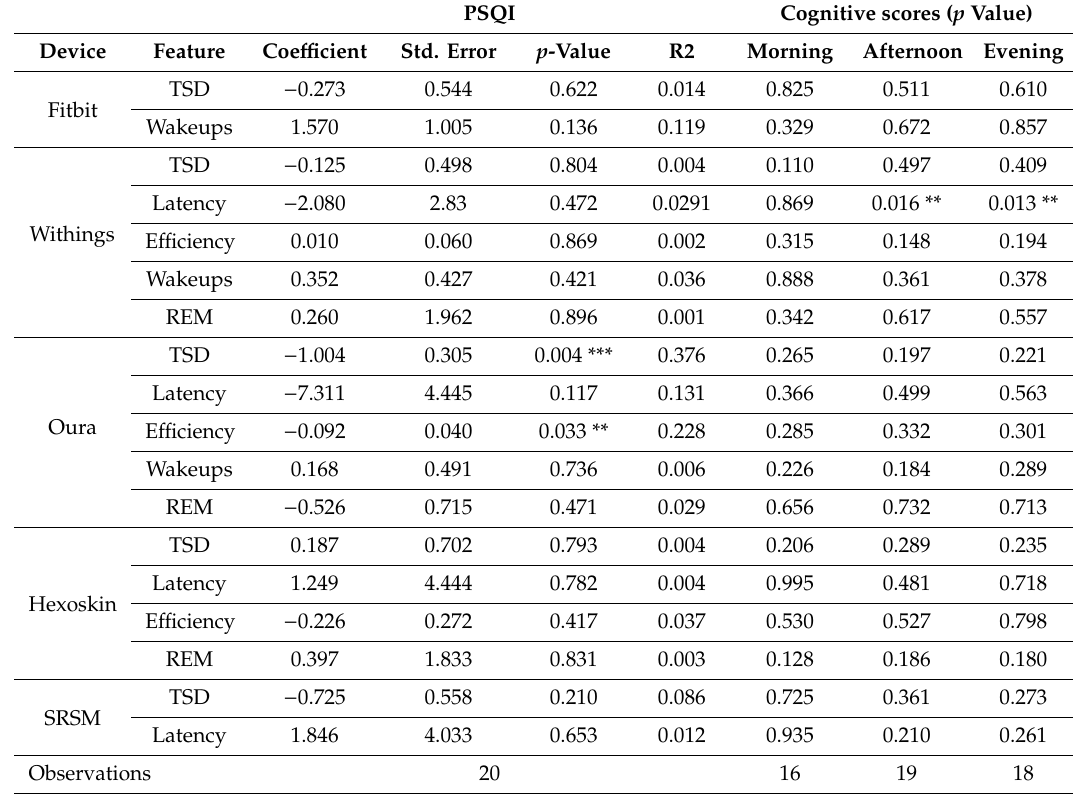
Table 3. Results of multiple univariate linear models for PSQI (left) and cognitive scores across all timepoints (right). For the PSQI-related models, the independent variables were the means of device data for each participant, and the dependent variable was PSQI. The higher the value is on the PSQI, the worse the sleep quality; thus, positive correlations suggest relation to poorer sleep quality. For the cognitive score-related models, the independent variables were the means of device data for each participant, and the dependent variable were the cognitive scores. We show the p values of each univariate regression for cognitive score by timepoint. Please see Supplemental S6–S8 for more statistics related to these regressions. All units are in hours with the exception of wakeups (number of occurrences) and e ffi ciency (a standardized metric).